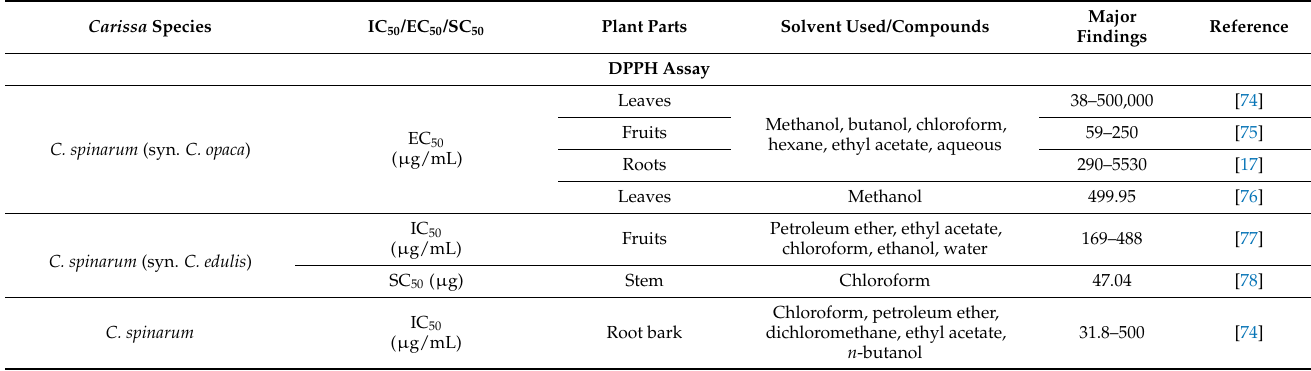
Table 3. Antioxidant potential of Carissa